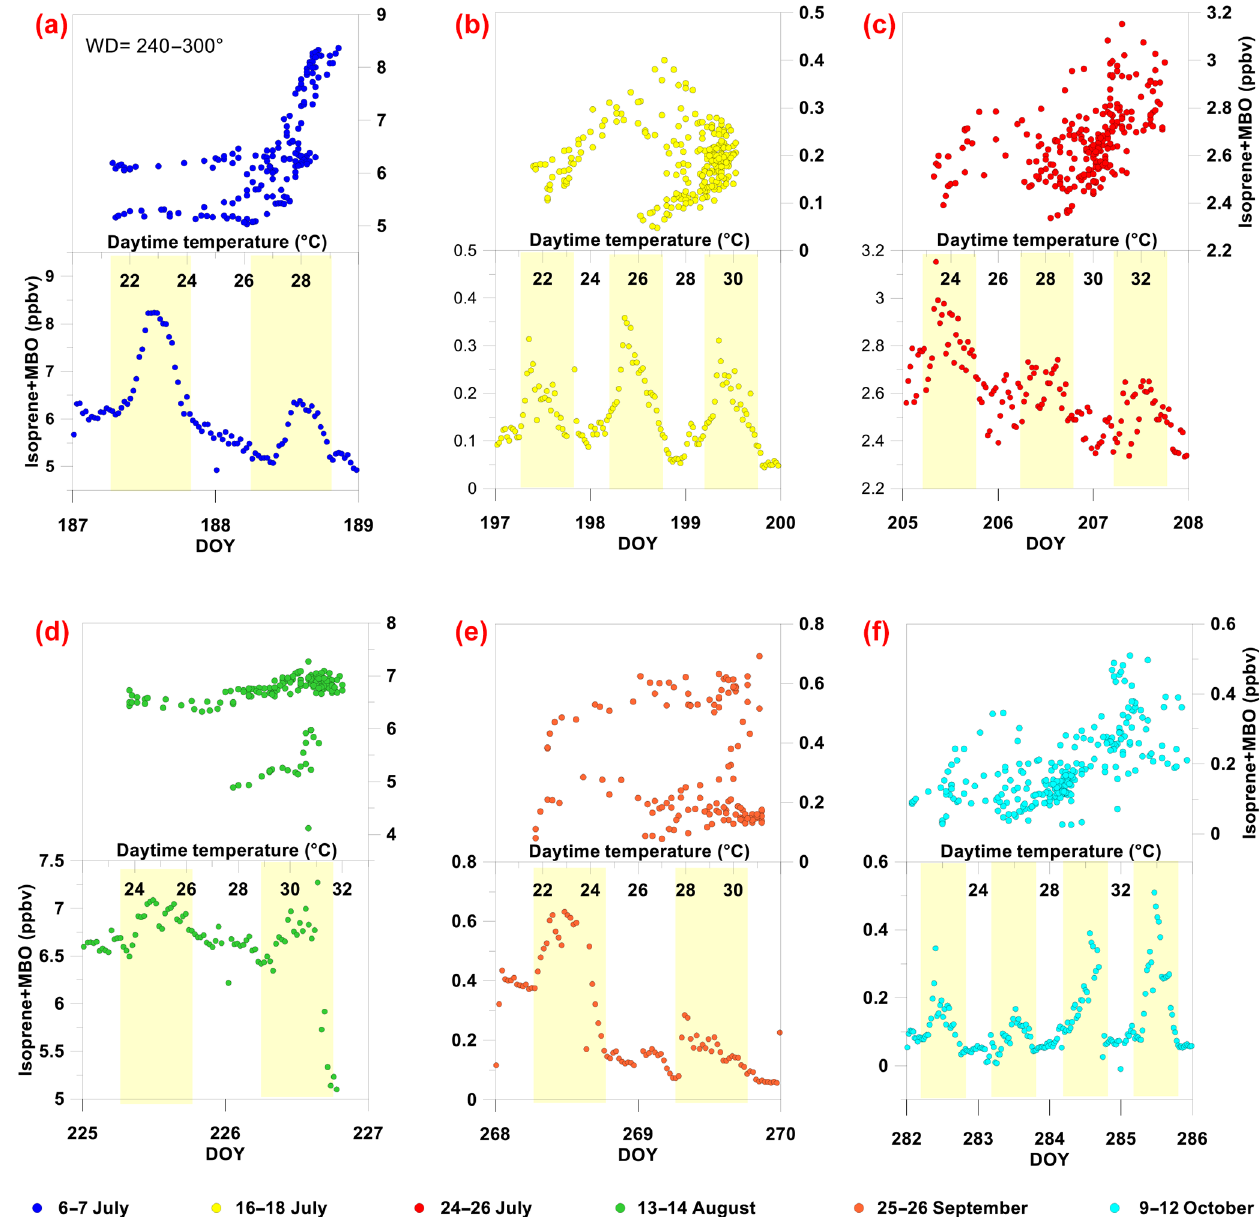
Figure 4. Isoprene + MBO (m69) diurnal average mixing ratios and time series. (a–f) Regression scatter of measured MBO + isoprene (ISP + MBO) vs. temperature (a, b, c) and the time series of isoprene + MBO (d, e, f) for the six measurement periods: DOY 187–188 (a) , DOY 197–199 (b) , DOY 205–207 (c) , DOY 225–226 (d) , DOY 268–269 (e) , DOY 282–285 (f) . The scatter of the measured MBO + isoprene vs. temperature (a, b, c) excludes measurements associated with wind direction from the memorial garden (90–150 ◦